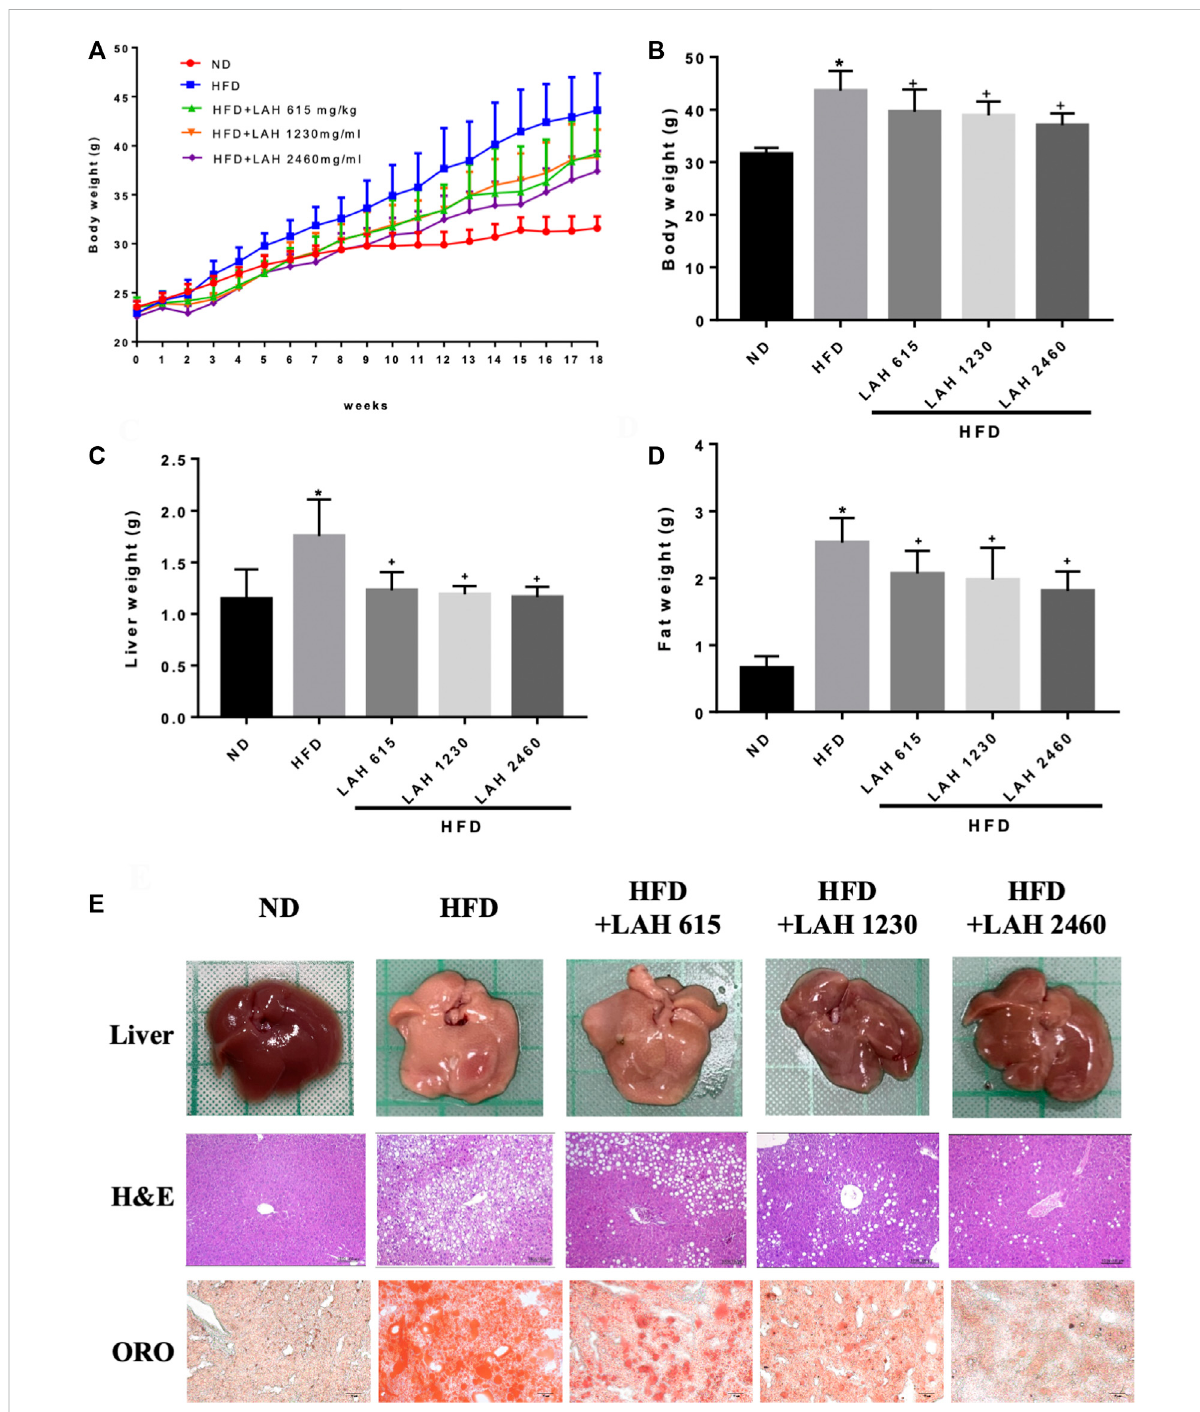
FIGURE 5 LAH ameliorated hepatic steatosis in HFD-induced mice. (A) Changes in body weight of mice fed either chow diet (ND), high-fat diet (HFD), or HFD containing 615 mg/kg,1230 mg/kg,or 2460 mg/kg LAH extract for 18 weeks, (B) fi nal body weight, (C) fi nalliver and (D) inguinal adiposetissue weights, (E) Morphological photographs of livers. Histological analysis of liver sections stained with hematoxylin-eosin (H&E) staining and oil red O (100 × magni fi cation). Values are expressed as mean ± SD ( n = 10/group). * p < 0.05 compared with ND group. + p < 0.05 compared with HFD